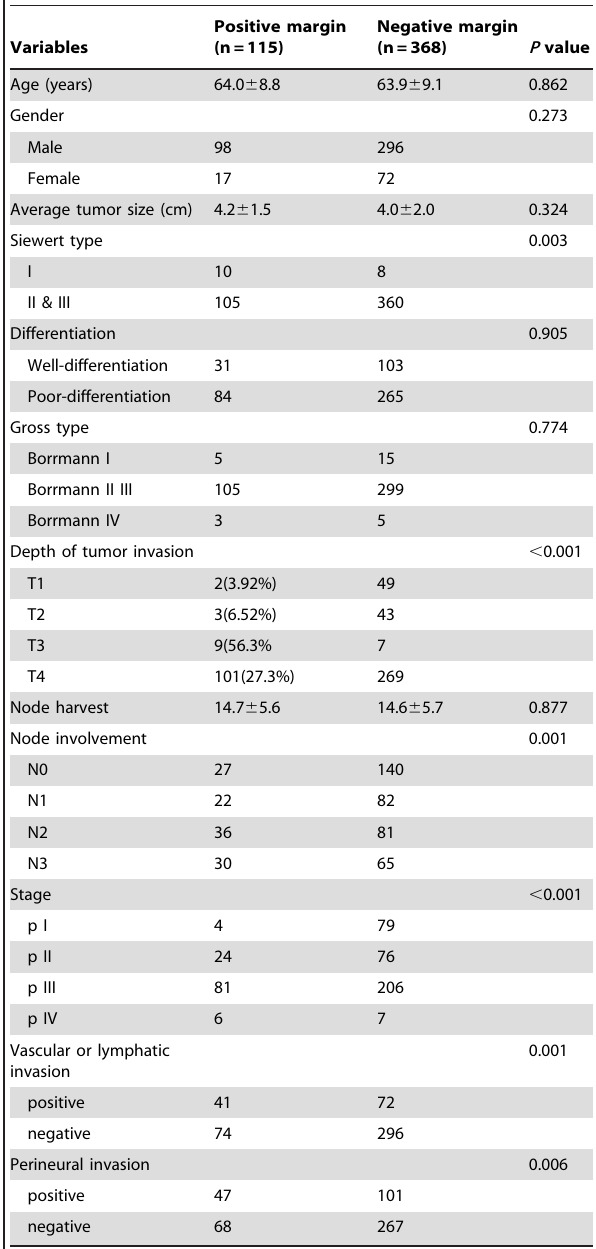
Table 1. Comparison of demographic and pathologic factors between patients with positive and negative proximal margins.